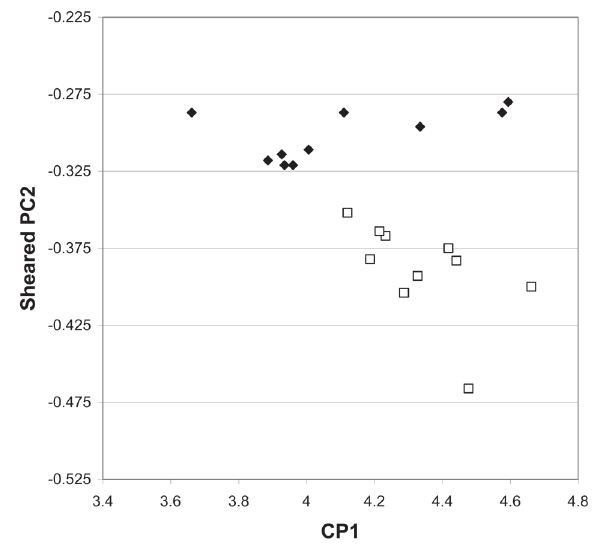
Fig. 5 . Dispersion of individual scores in the first and second axes of principal component analysis with shear. Dark diamonds = A. aff. scabripinnis (1850m); Clear square = A. aff. scabripinnis (662m).